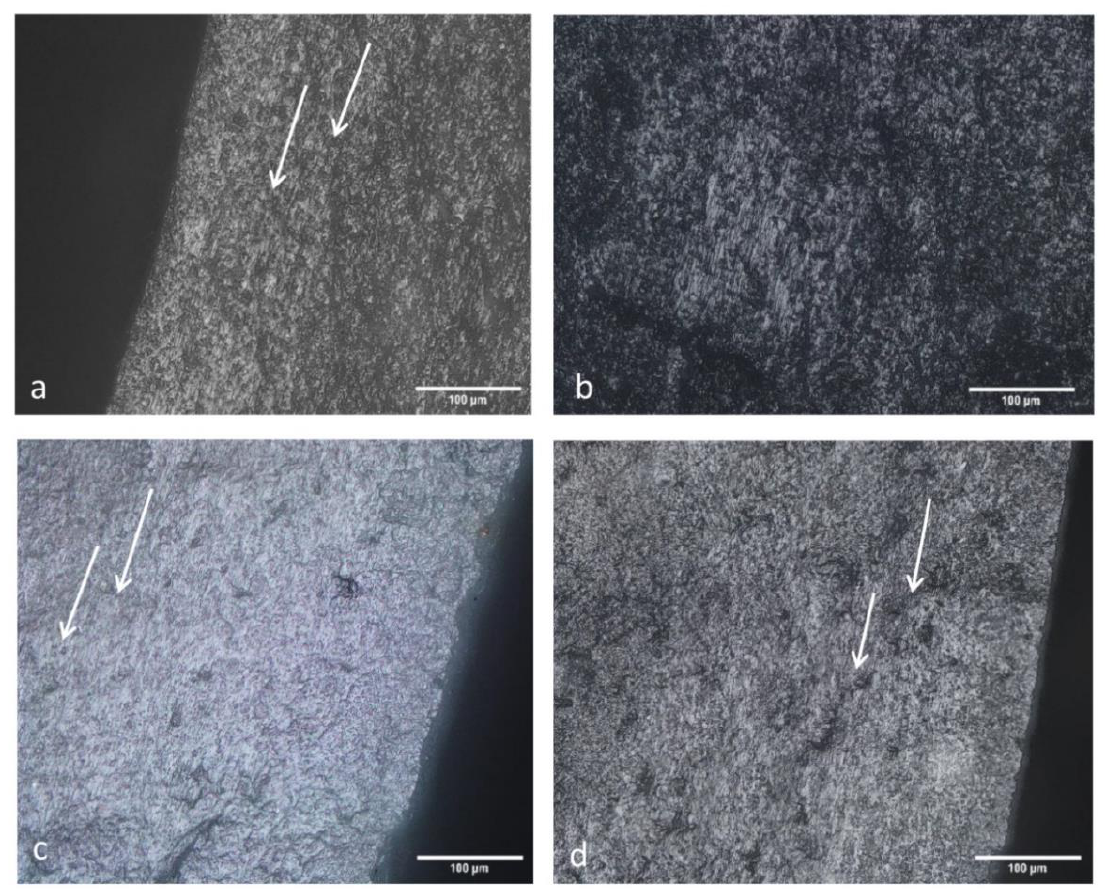
Figure 8 . a)+b) Experimental burin (EXP16_2) (cf. Rots, 2010) used on soaked antler with